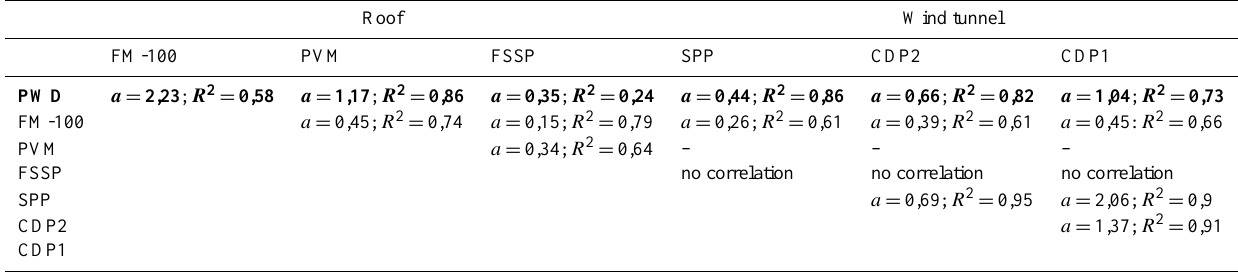
Table 3. Summary of the cloud extinction coefficient intercomparison performed during ROSEA. The coefficient a is the slope of the linear regression; the correlation coefficient R 2 is also indicated. The bold parts correspond to the standardization of each instrument according to the PWD; the values given by the fitting coefficient a correspond to the factor of standardization.